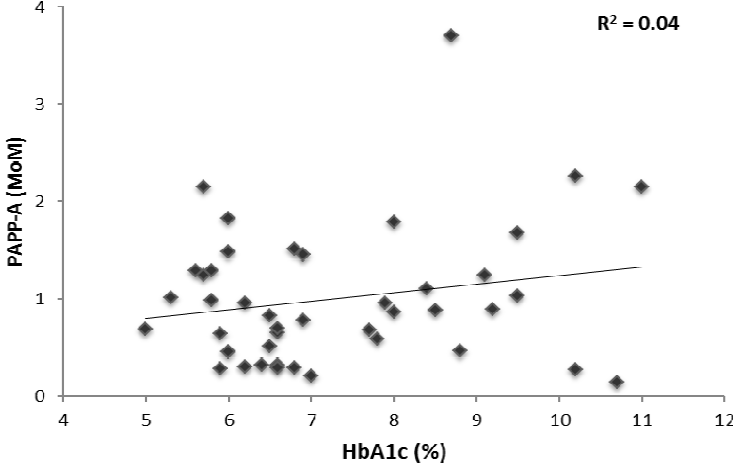
Figure 2. Scatter plot showing the correlation between pregnancy associated plasma protein-A (PAPP-A) multiples of median (MoM) and glycosylated hemoglobin percent (%).